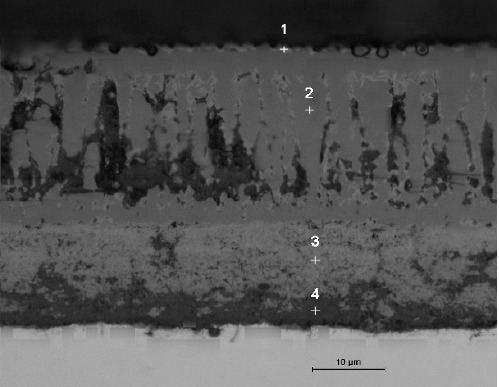
Figure 6. Cross-sectional morphology and EDS analysis at different positions of the iron oxide scale at 900 °C. Table 2. The elemental distribution of the energy spectrum.